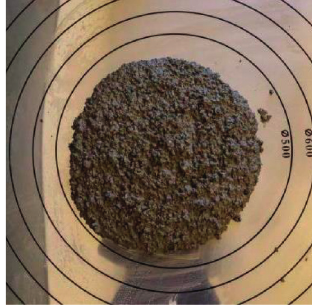
Figure 6: Slumping area